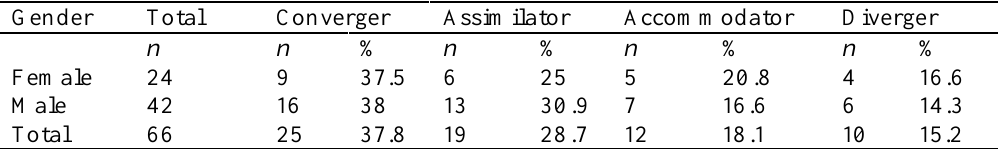
Participant’s Learning